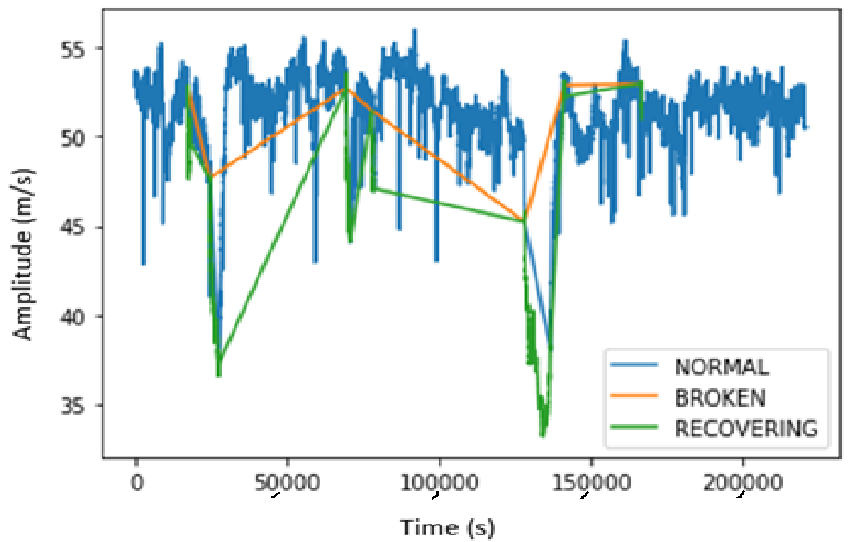
Figure 4. Distribution of sensor values of sensor 2.